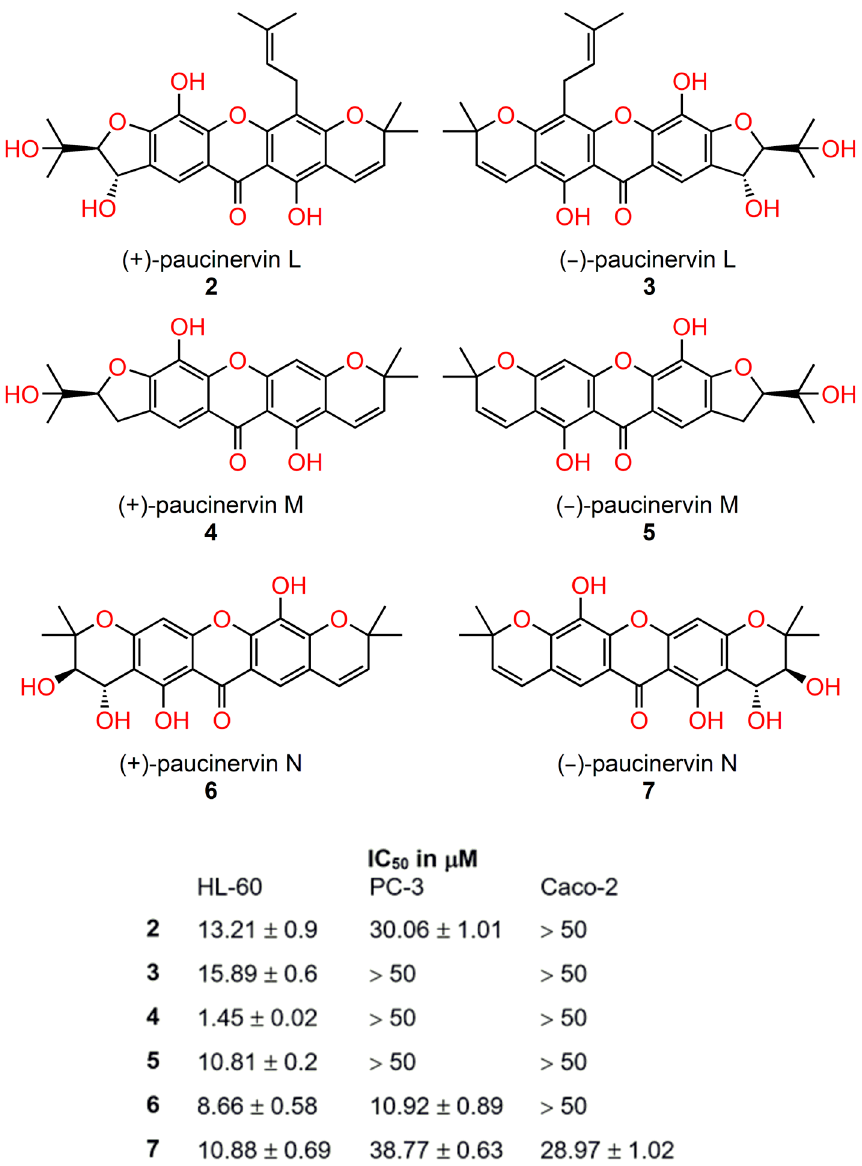
Figure 7. The structure and cytotoxic activity of the new chiral paucinervin enantiomers with an antiproliferative effect [77].